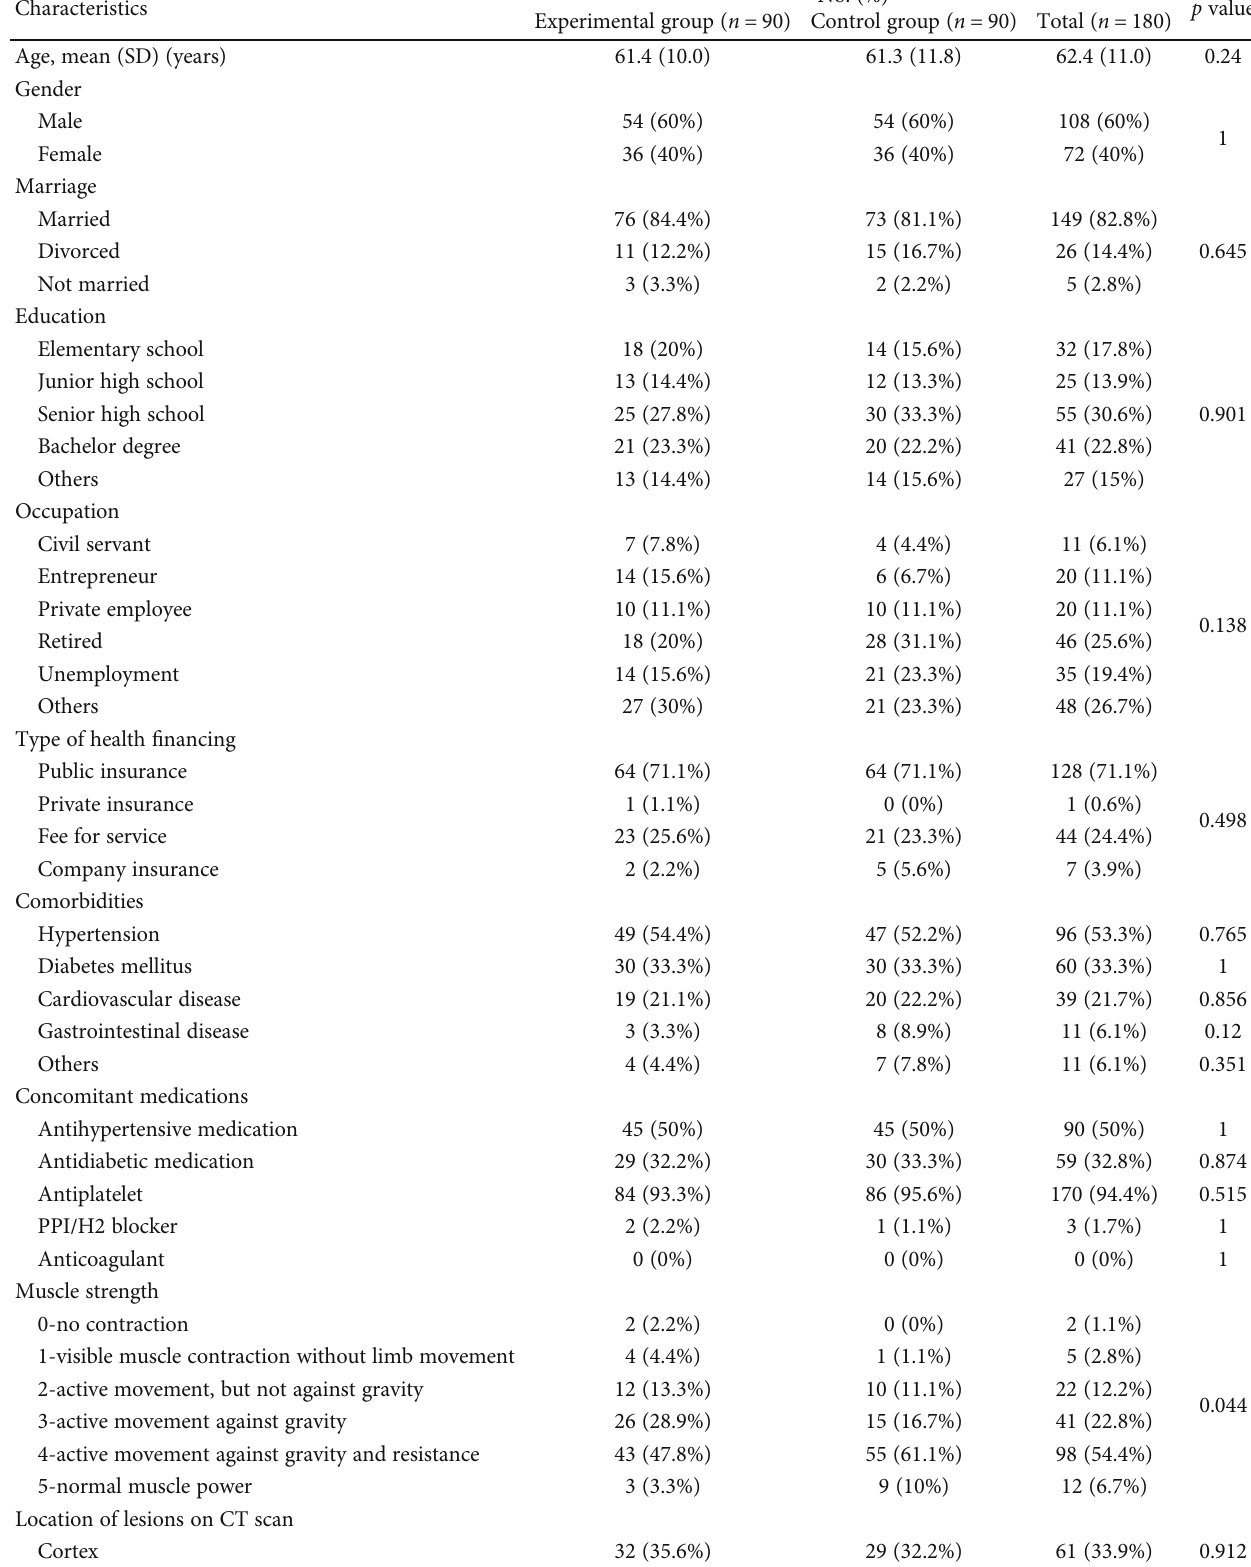
Table 1: Subjects ’ clinical